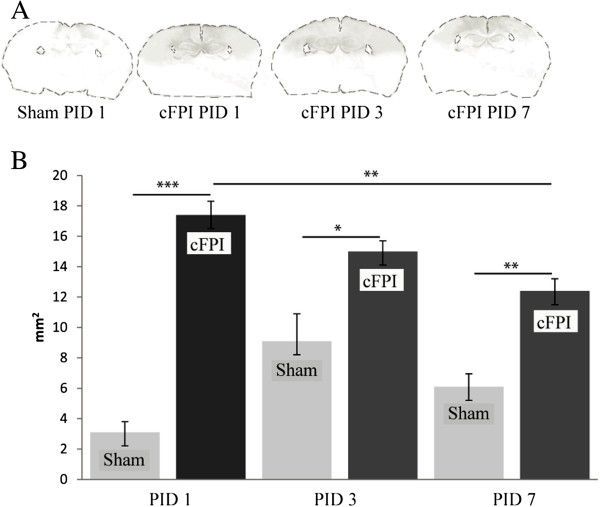
Blood-brain barrier leakage evaluated by mouse IgG staining. (A) Representative images of blood–brain barrier leakage of sham- and brain-injured animals, identified by IgG staining in the brain regions underlying the craniotomy and impact site; (B) Quantitation of the area (mm2) stained with IgG (above the pre-set intensity level) at 1, 3 and 7 days after sham injury or central fluid percussion injury (cFPI), presented as means ± SD. The IgG staining was more intense in sham-injured controls at 3 days compared the 1 and 7 days post-injury time points, although without reaching statistical significance. *P<0.05; **P<0.01; ***P<0.001 compared to sham-injured controls. PID: Post-injury day.